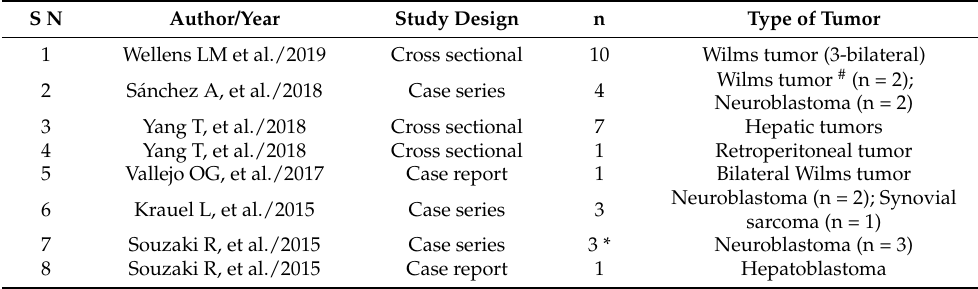
Table 1. Characteristics of the included